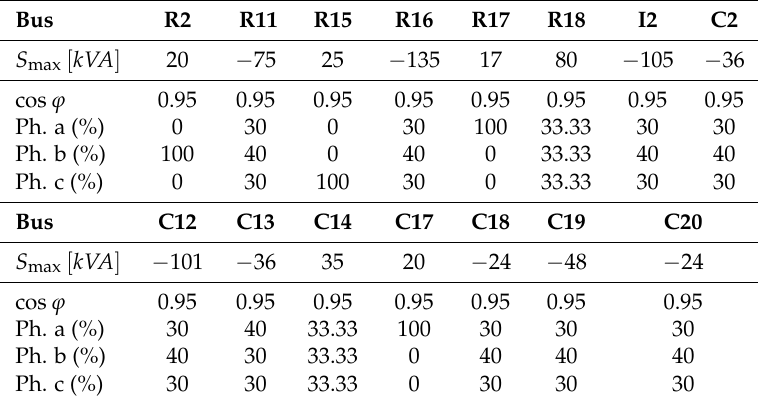
Table 7. Load/distributed generation configuration.